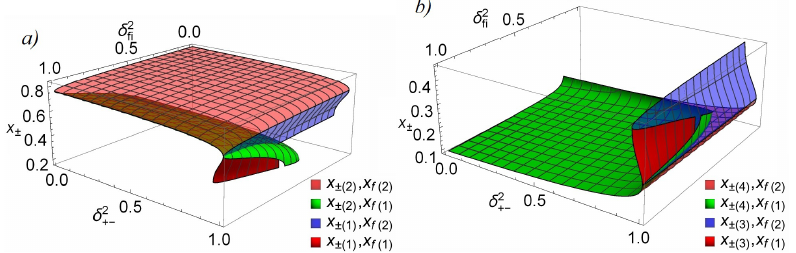
(cid:16) (cid:17) δ 2 , δ 2 + − (see Expressions (23) and (24)) on the outgoing fi